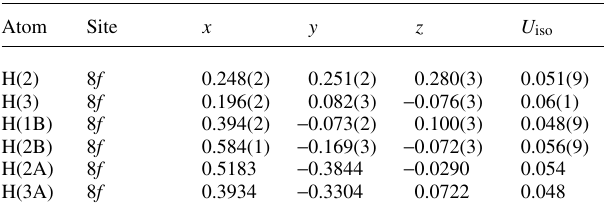
Table 2. Atomic coordinates and displacement parameters (in Å 2 )